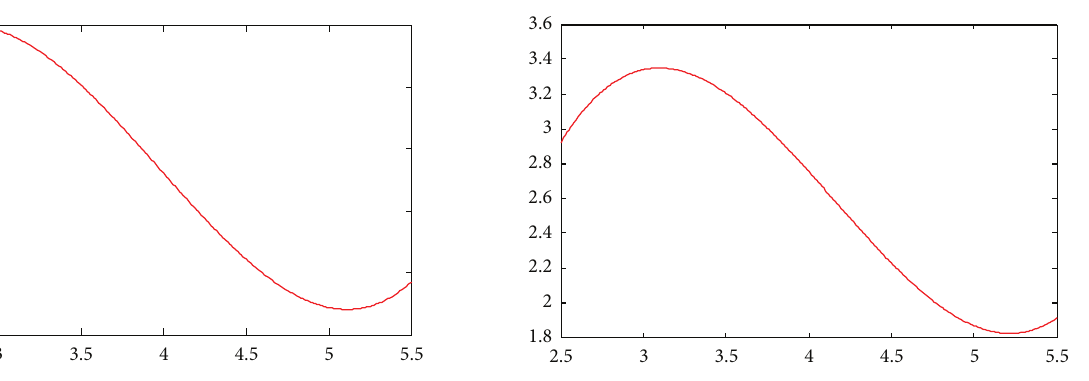
Figure 4: The diagram of Malmquist product index DMU 4 .